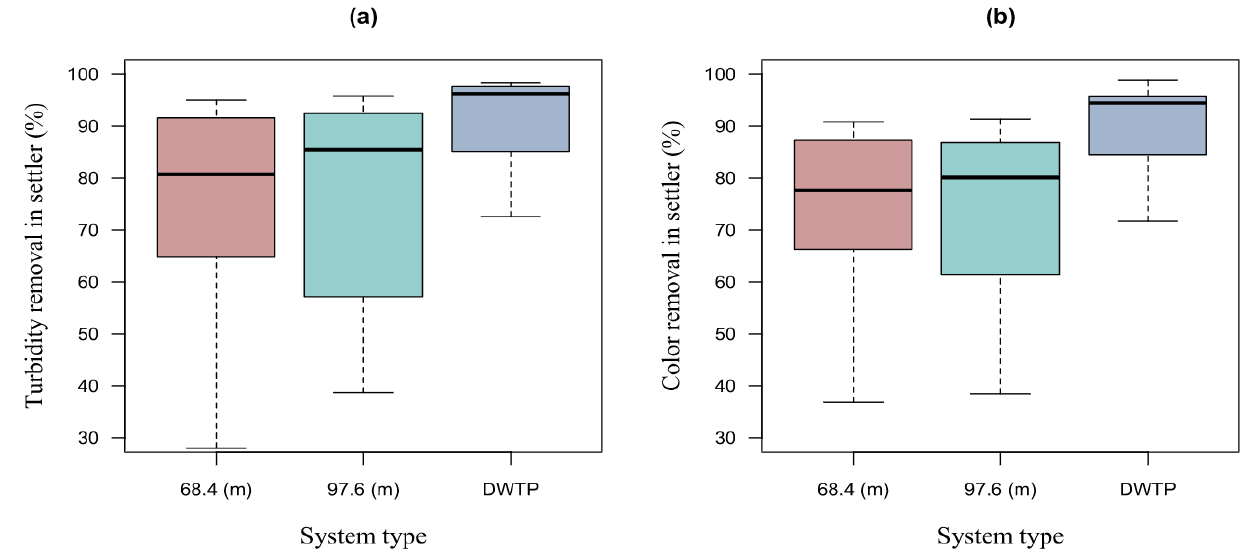
Figure 11. Average, maximum, and minimum values of RE in the pilot settler with HTF of 68.4 m, with HTF of 97.6 m, and in the settler of the DWTP Bayas: ( a ) Turbidity and ( b ) color. The pink boxes correspond to the PTS with a 68.4m long tubular flocculator, the turquoise boxes correspond to the PTS with a 97.6m long tubular flocculator and the Light Steel Blue boxes correspond to the “Bayas” DWTP.